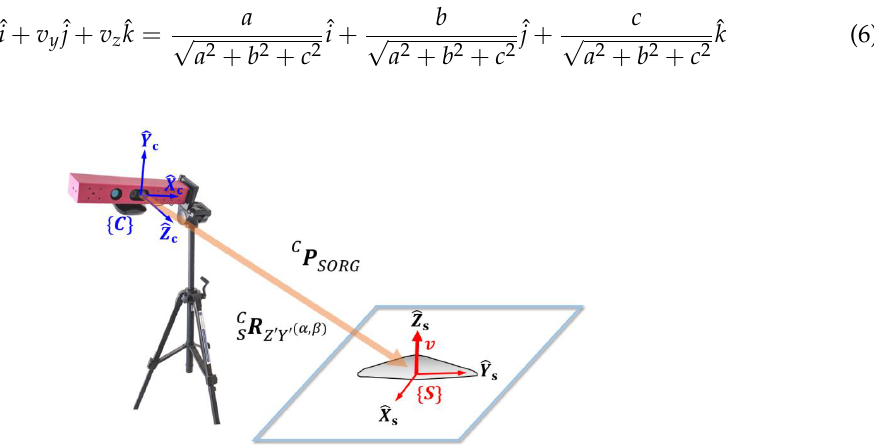
Figure 4. Kinect camera frame {C} and slump frame {S}. v is the unit vector on the Z -axis of slump frame {S}.